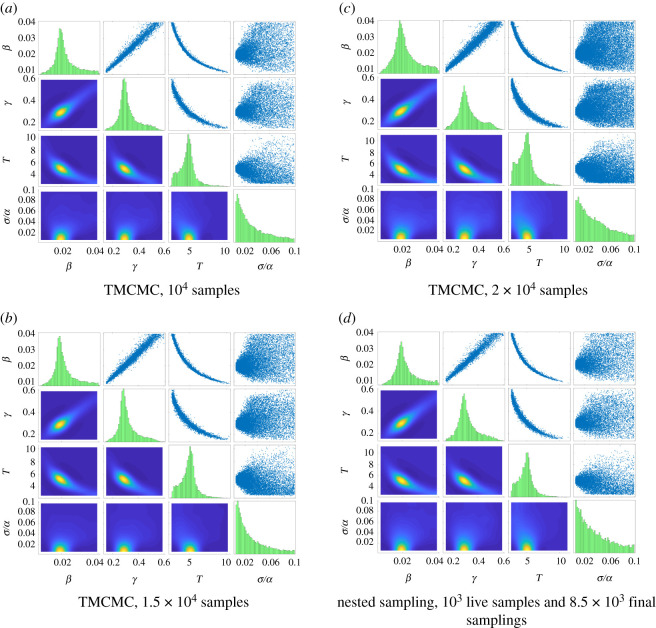
TMCMC and nested sampling results for the posterior distribution of figure 2b. (a) TMCMC, 104 samples, (b) TMCMC, 1.5 × 104 samples, (c) TMCMC, 2 × 104 samples, (d) nested sampling, 103 live samples and 8.5 × 103 final samplings.